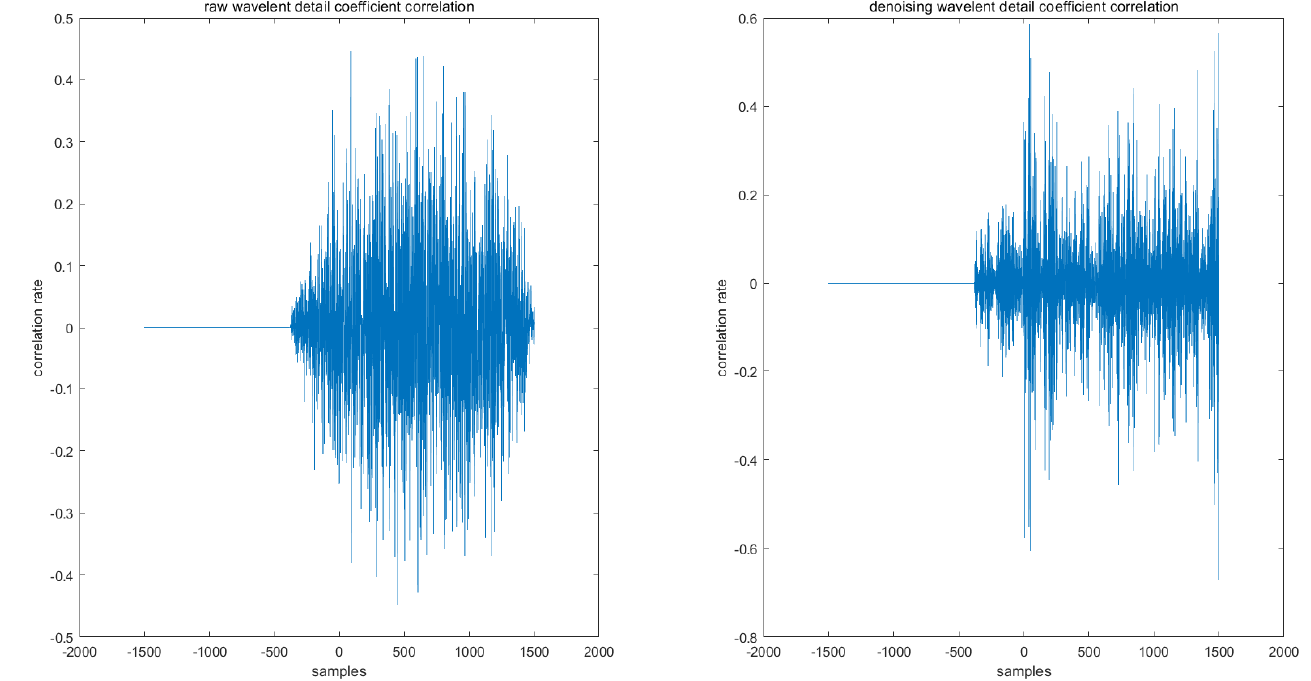
Figure 7. The correlation between the different levels of wavelet detail coefficients.